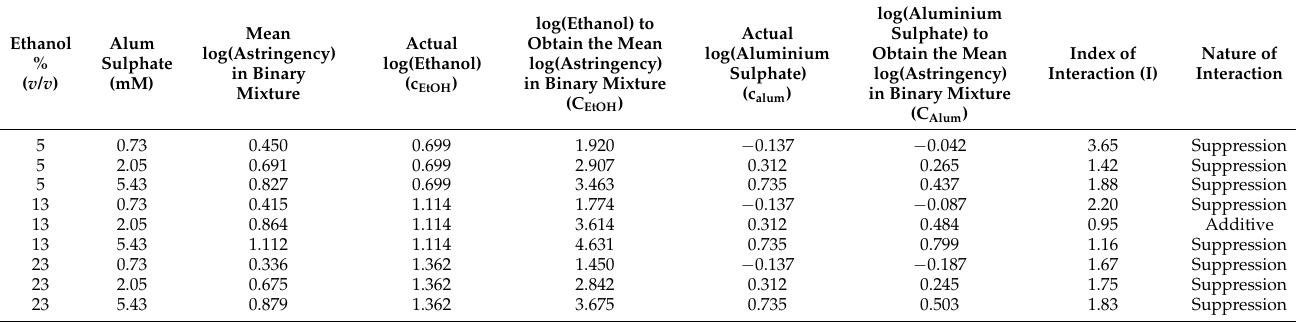
Table 4. Isobole calculations for astringency interactions in binary mixtures of ethanol and aluminium sulphate ( n = 36).